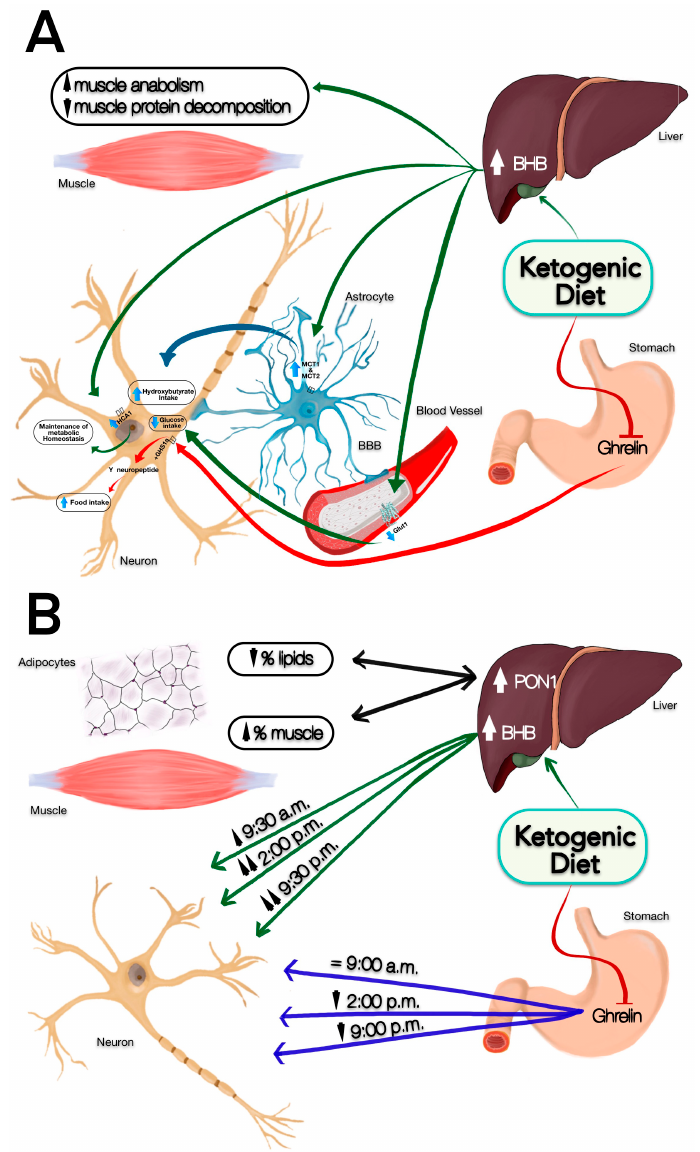
Figure 2. The effects of the ketogenic diet on different organs. ( A ) The beta-hydroxybutyrate (BHB) ketone body changes the way energy is used in the brain, increasing medium-chain triglycerides (MCT)1 and MCT4 in the astrocytes, which are part of the blood-brain barrier (BBB) and decreasing glucose transporter 1 (GLUT1) of the blood vessels of the BBB, being responsible for transporting ketone bodies and glucose, respectively, to the Central Nervous System (CNS). Ketone bodies have anabolic and anti-catabolic activity in the skeletal muscle. Finally, ghrelin joins its specific receptor (GHS1a) within the CNS, activating the Y neuropeptide. ( B ) Possible effects of the ketogenic diet on different organs y molecules (PON1). After the intervention, an increase in BHB production was observed. In addition, the increased perception of satiety during lunch and dinner raises the possibility that this increase will be greater in these temporal intervals (2:00 p.m and 9.30 p.m) depending on the time of administration of coconut oil. Regarding ghrelin, fasting levels are maintained as before the start of the intervention. However, depending on the interaction with the production of ketonic bodies already described, the production could decrease coinciding with the increase of BHB (2:00 p.m and 9.30 p.m). These two associated processes may explain the increase in muscle and the decrease in fat. Both aspects would be related to a better metabolic profile, evidenced by the higher production of PON1 in the liver as an anti-inflammatory